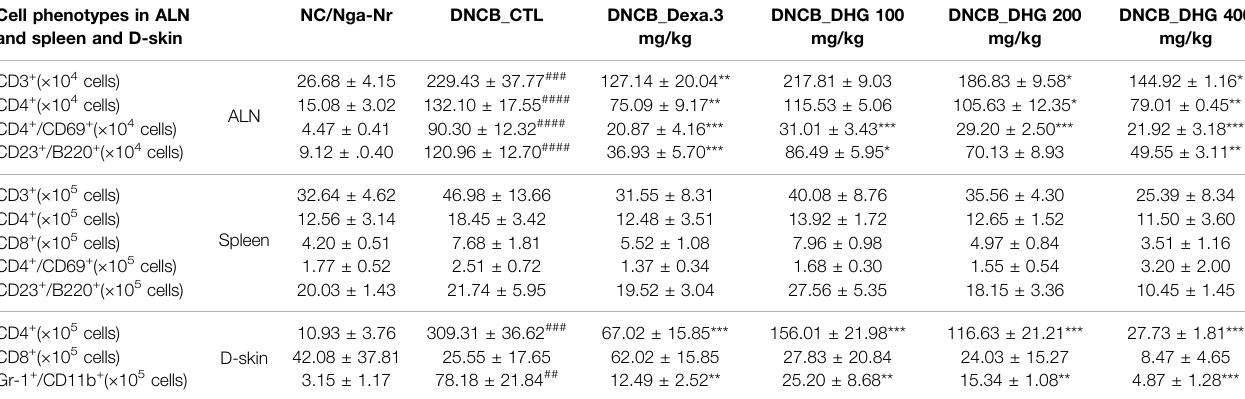
TABLE 2 | The effects of DHG on ALN and spleen and dorsal skin tissue immune cell absolute number. Cell phenotypes in ALN and spleen and D-skin